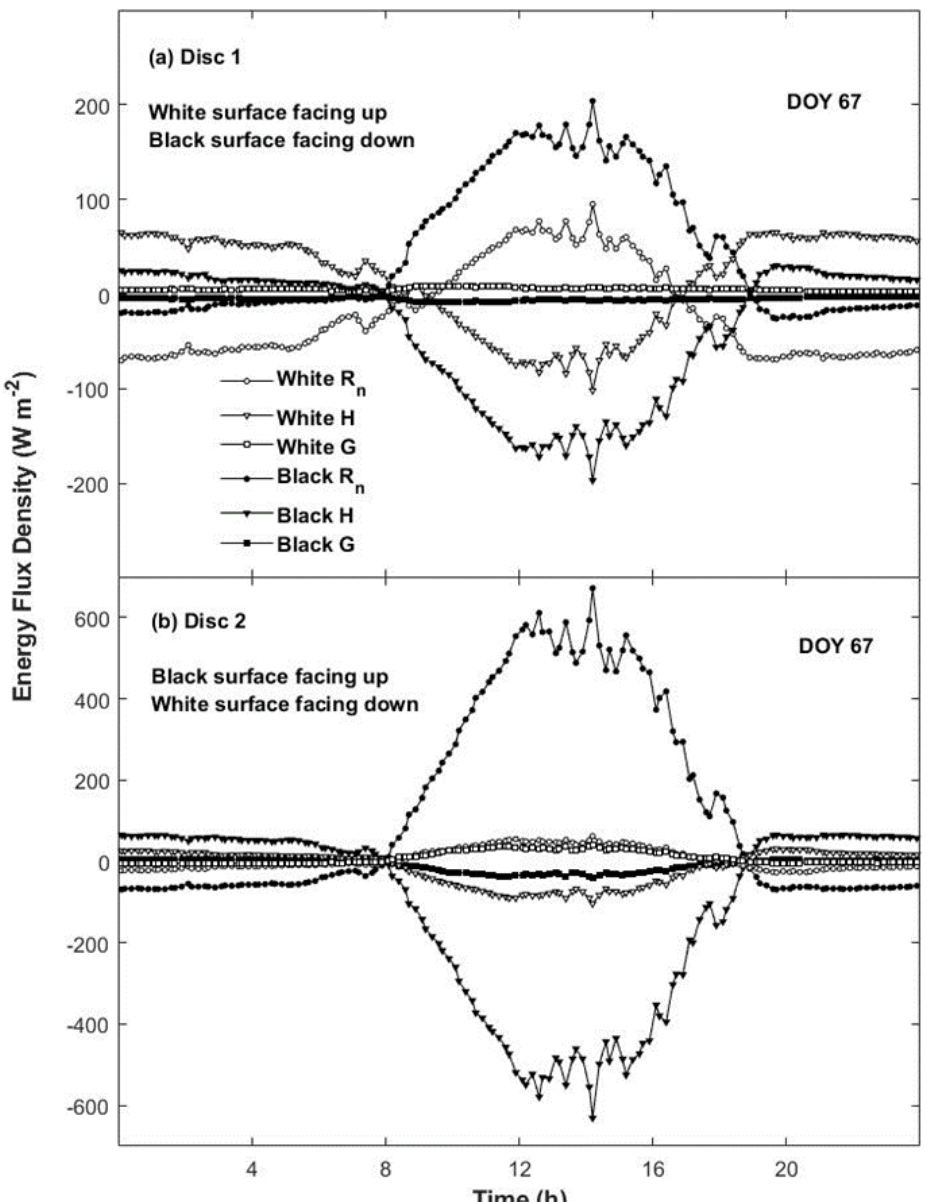
Figure 7. Energy balance components for ( a ) Disc 1 and ( b ) Disc 2 on day of year (DOY) 65. Sign convection dictates that energy fluxes toward the surfaces of the disc are positive and fluxes away from the surfaces are negative.